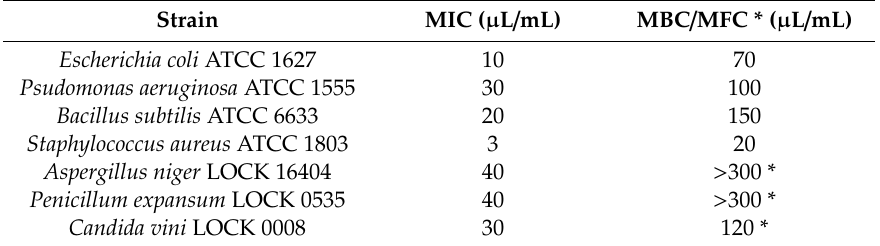
Table 4. Antimicrobial activity of essential oil from sonicated celery seeds.